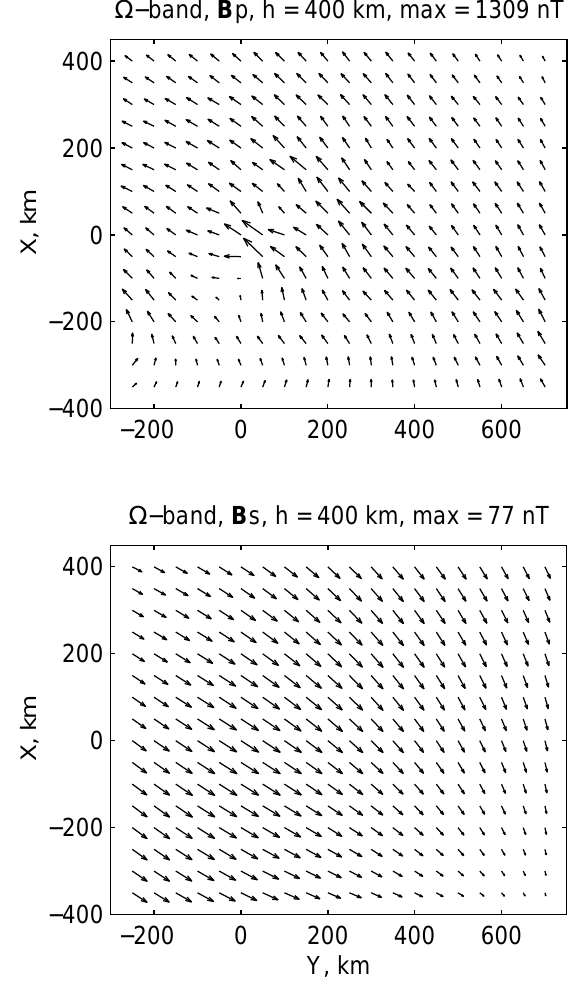
Fig. 11. The horizontal part of the primary and secondary mag- netic fields of the (cid:127) -band model at an altitude of 400km. Note the different scales of the plots.